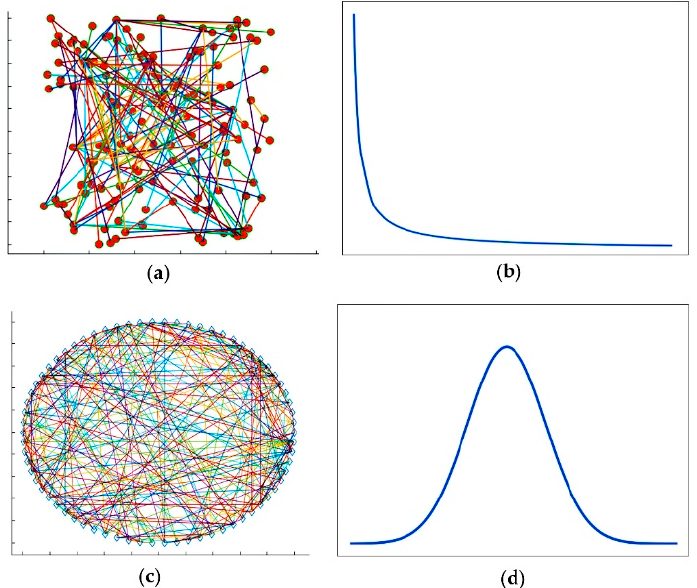
Figure 1. Comparison diagram of the scale-free network and the random network: ( a ) visualization of the scale-free network; ( b ) the degree distribution curve of nodes in the scale-free network; ( c ) visualization of the random network; ( d ) the degree distribution curve of nodes in the random network. Additionally, Barabasi and Reka Albert proposed the classical BA model for construct- ing the scale-free network. The specific structure of the BA model is as